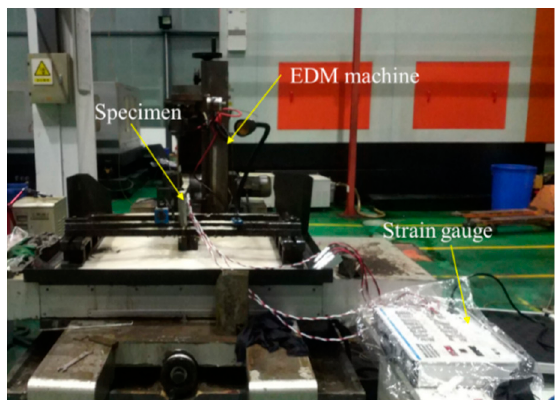
Metals 2020 , 10 , x FOR PEER REVIEW Figure 4. Measurement of the initial residual stress. Figure 4. Measurement of the initial residual stress.